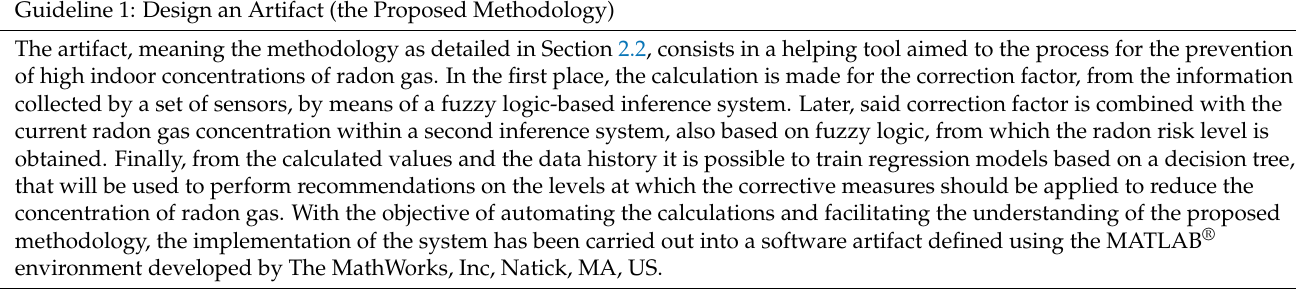
Table 2. Verification of the guidelines in Hevner et al.